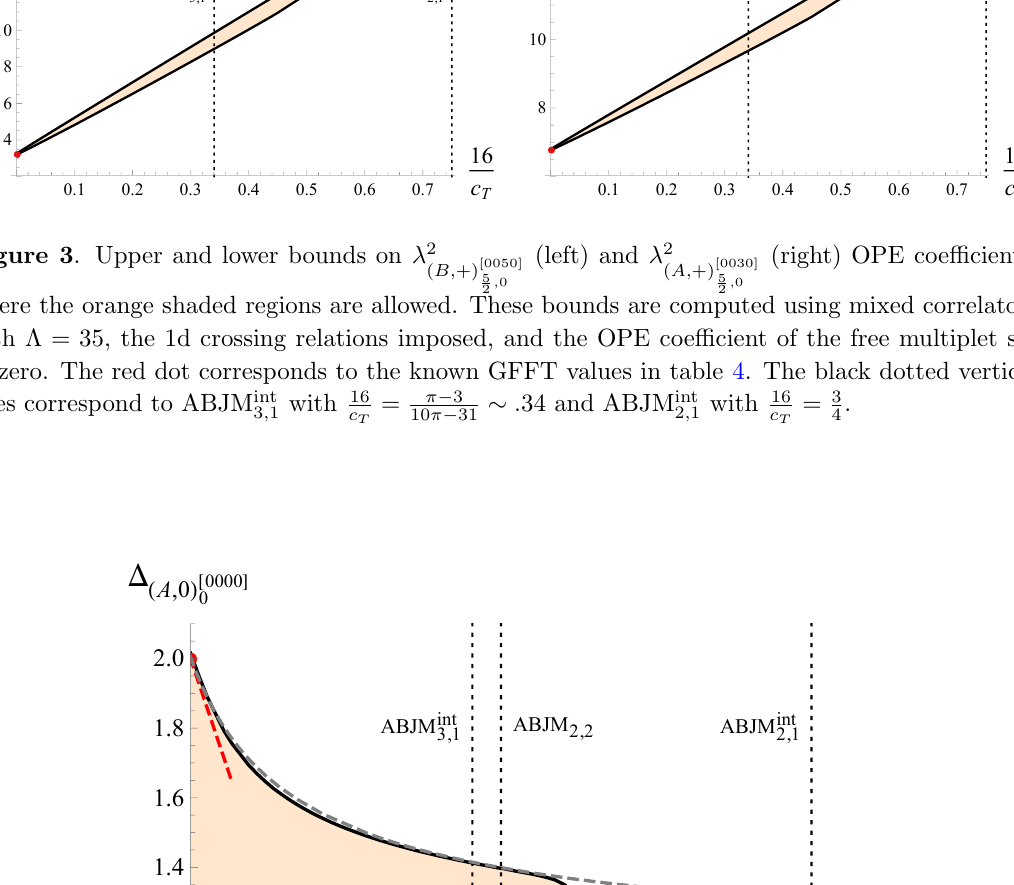
Figure 4 . Upper bounds on the scaling dimension (cid:1) of the lowest dimension scalar long ( A; 0) [0000] (cid:1) ; 0 multiplet ( A; 0) [0000] . The black line was computed using the mixed correlators introduced in this (cid:1) ; 0 work with (cid:3) = 27, the 1d crossing relations imposed, and the OPE coe(cid:14)cient of the free multiplet set to zero. The gray dotted line corresponds upper bounds computed using just the h 2222 i correlator in [39] with (cid:3) = 43, and without any 1d crossing relations or conditions on the free theory imposed. The red dotted line shows the 1 correction computed in [63]. The black dotted vertical lines c T (cid:24) = ABJ 16 correspond to ABJM int with 16 = (cid:25) (cid:0) 3 (cid:24) : 34 and ABJM int = 3 . 1 with 3 ; 1 2 ; 1 c T 10 (cid:25) (cid:0) 31 c T 4